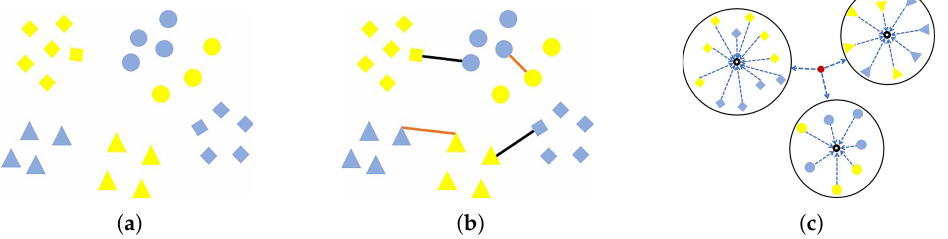
Figure 2. ( a ) Two different original domains (yellow and blue); ( b ) Applying pairwise samples including similar pairs (orange lines) and dissimilar pairs (black lines) constraints to the original domains; ( c ) Forcing the feature vectors from the same class to their mean vectors (black circular rings), and meanwhile keeping the mean vectors of different classes away from the total mean vector (the red